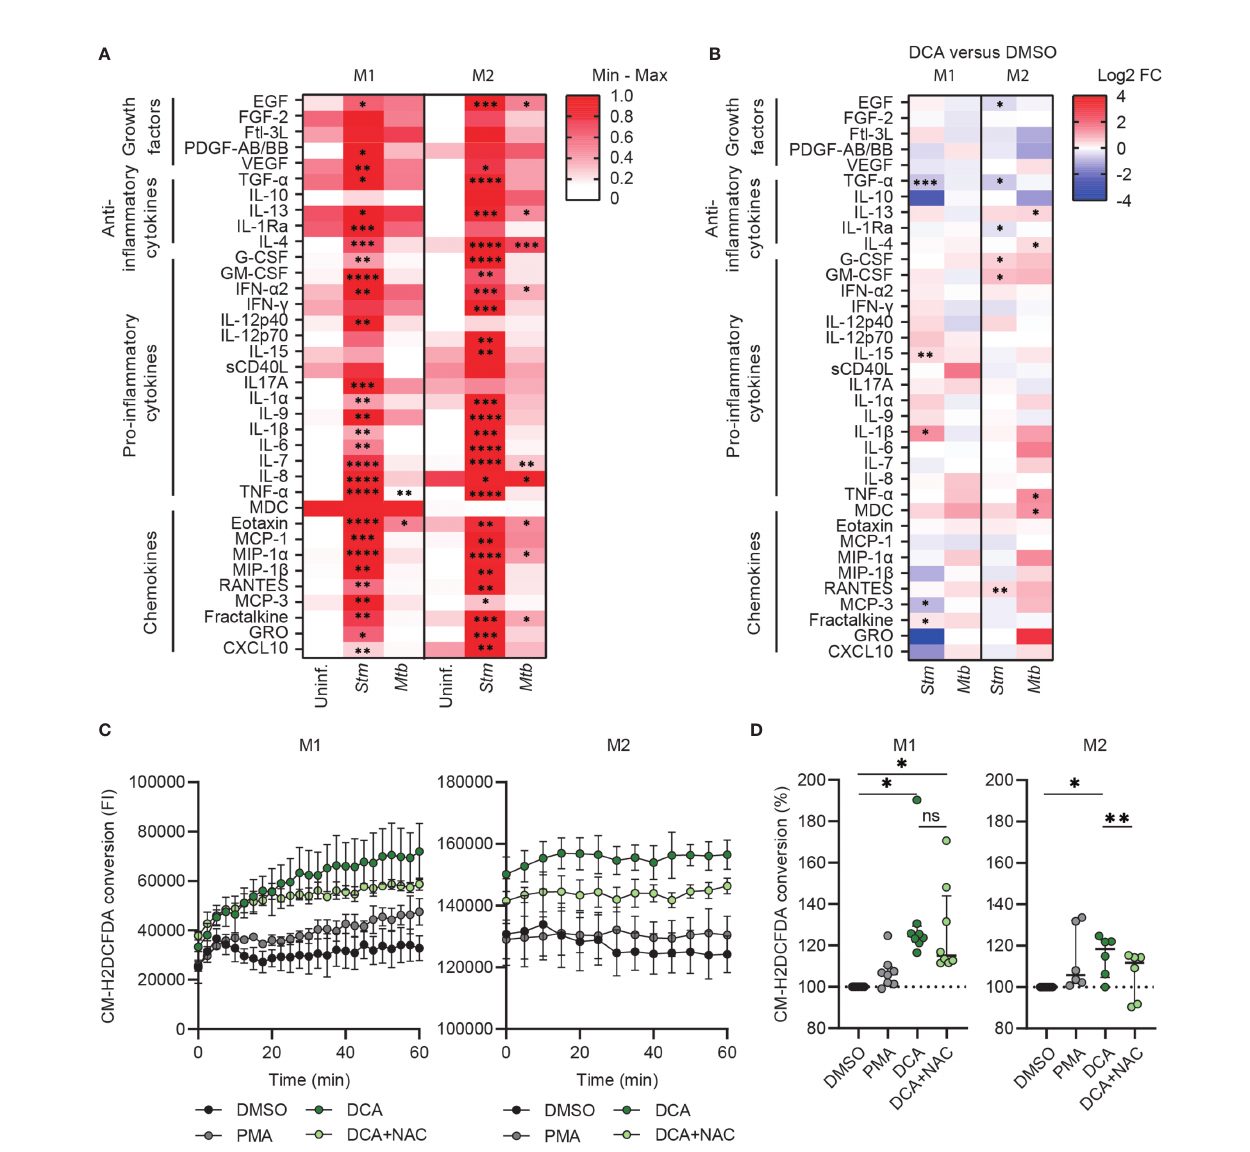
FIGURE 5 | DCA induced ROS production and did not induce major cytokine/chemokine production in human macrophages. (A) Heatmap displaying median cytokine/chemokine levels in the supernatants of uninfected, Stm- or Mtb- infected M1 and M2 obtained from six donors. Shown are the relative secretion levels (>10 pg/ml) on a white to red color scale per cytokine/chemokine (min=0; max=1). Signi fi cant differences were tested by RM one-way ANOVA with Dunnett ’ s multiple comparison test against the corresponding uninfected control. (B) Heatmap displaying median log2 fold change (FC) cytokine/chemokine levels relative to vehicle control DMSO in the supernatants of Stm - or Mtb -infected M1 and M2 obtained from six donors. Stm- or Mtb- infected macrophages were treated with DCA (10 mM) or an equal volume of DMSO (0.1% v/v) overnight. Differences were signi fi cant by a paired t-test between DMSO and DCA. (C, D) ROS production in M1 (left panel) and M2 (right panel) was measured kinetically for 60 min in cells that were treated with DCA (10 mM), PMA (300 nM) or vehicle control DMSO (0.1% v/v). Data represent the fl uorescent intensity (FI) at 522 nm measured kinetically of one representative experiment (C) and the median ± interquartile range of the area under the curves (AUC) of the FI normalized to control (i.e. DMSO) of minimally six donors (D) . Signi fi cant differences were tested by RM one-way ANOVA with Tukey ’ s multiple comparison test. *p < 0.05, **p < 0.01, ***p < 0.001, ****p <